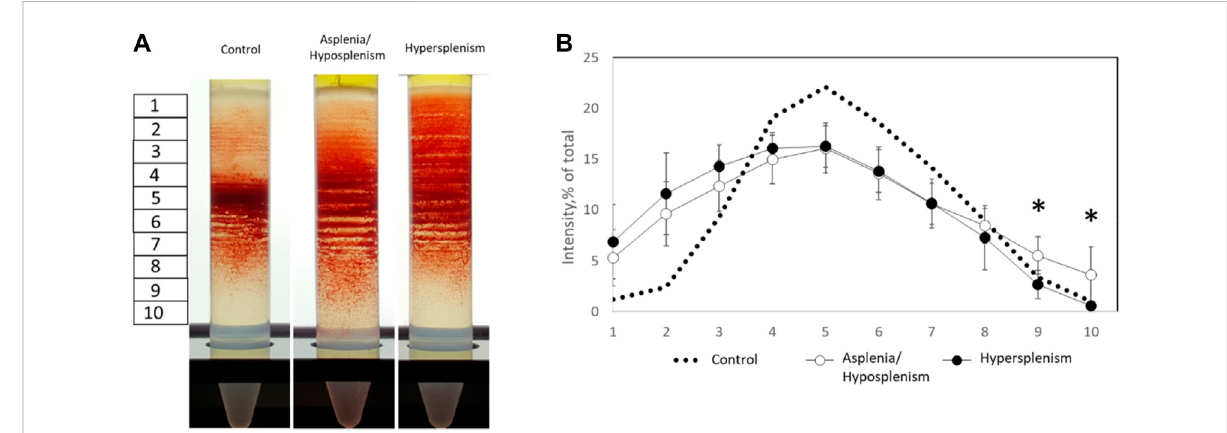
FIGURE 1 Percoll density gradients of control and SCD subjects for dense and hydrated RBC fractions. (A) Representative Percoll gradients for control, asplenic/hyposplenic,andhypersplenicsubjectsaredemonstrated. (B) TheRBCcontentineachstationwasestimatedasapercentagefromasumof all sub-fraction intensity values. The correspondent examination of RBCs obtained from control subjects ( n = 21; 10M/11F; 46.8 ± 14.2 years) was made. The data is presented in average ± SD; the signi fi cance is < 0.05.